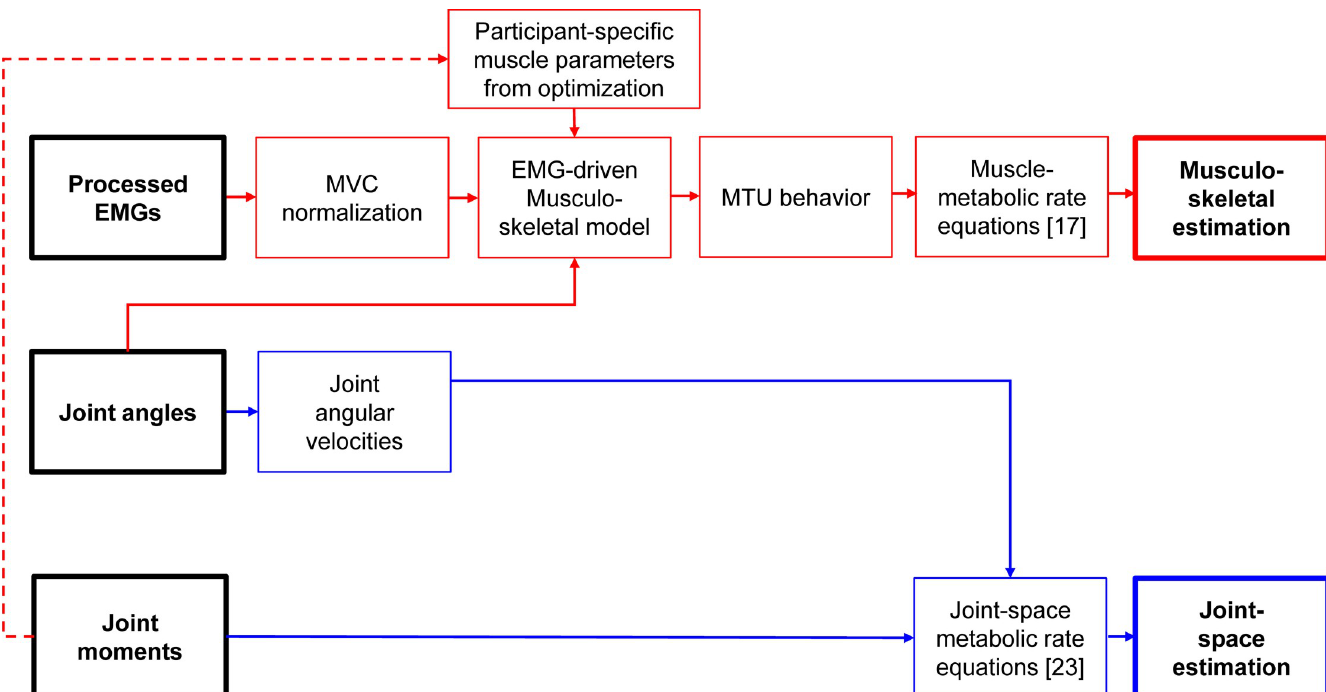
Fig 1. Flow chart of both metabolic rate time profile estimation methods. The musculoskeletal estimation method uses a musculoskeletal model driven by joint kinematics and EMG signals in conjunction with the muscle metabolic cost equations [17]. This method also used joint moment data for optimizing the participant- specific muscle parameters but not for the metabolic rate estimation. The joint-space estimation method uses only the joint kinematics and joint moments as inputs [23].